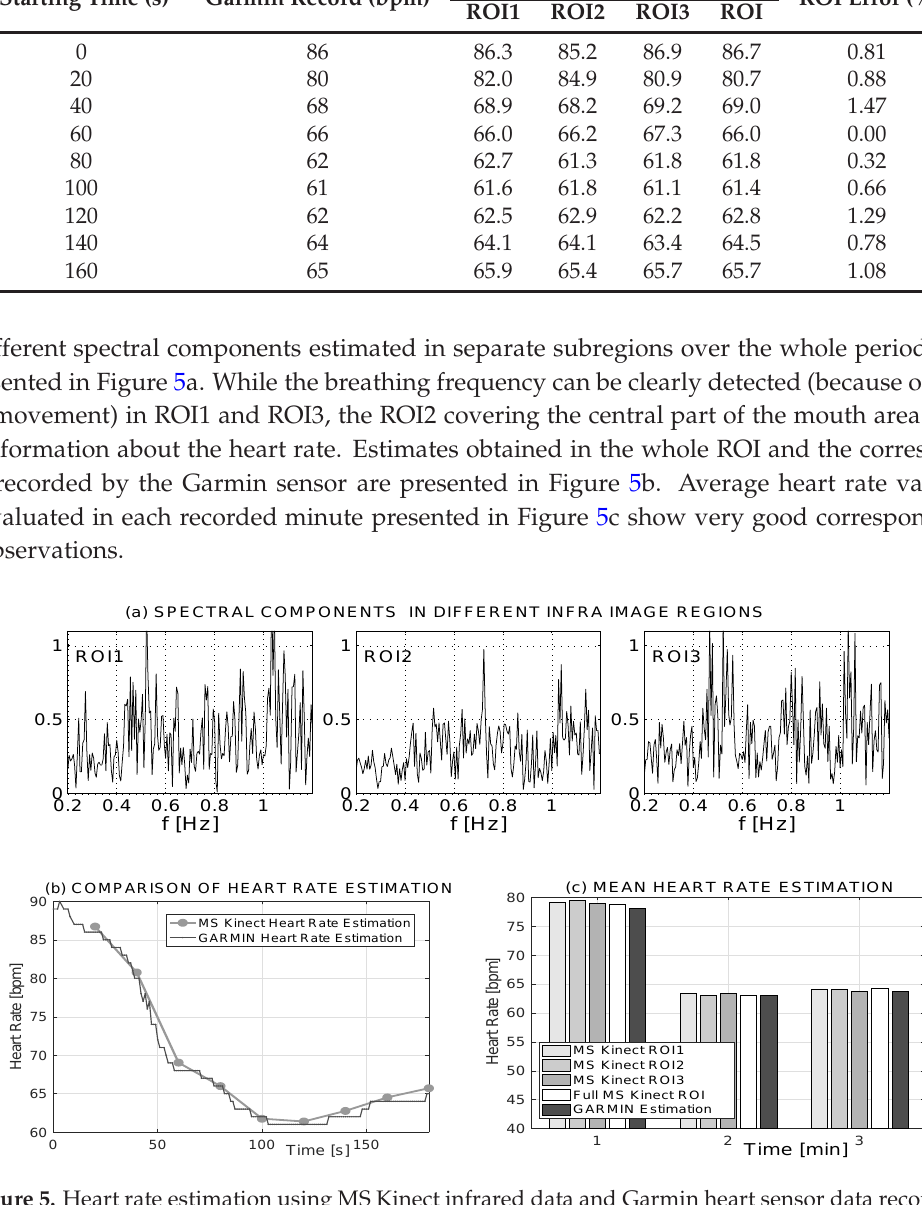
Table 2. Estimates of heart rate (HR) evaluated for a 20 s window length by an MS Kinect infra sensor in the full region of interest (ROI) and its subregions in the mouth area compared with Garmin records. Kinect HR (bpm) Estimate Starting Time (s) Garmin Record (bpm)